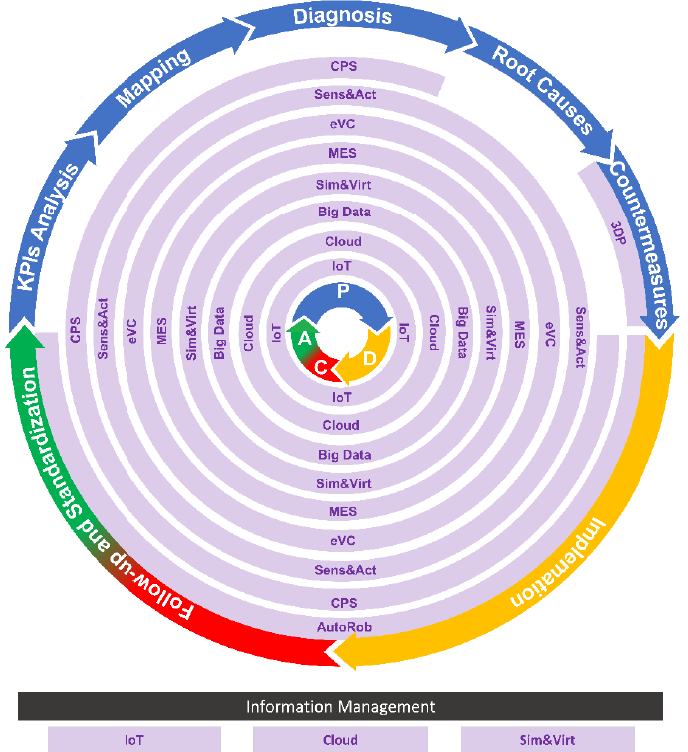
Figure 4. I4.0 technological concepts for the PDCA 4.0 methodology.